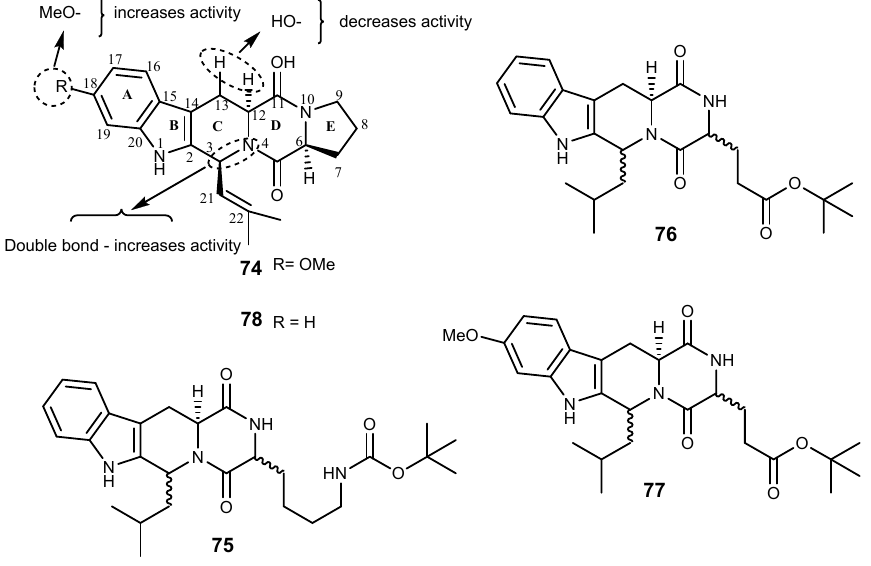
Figure 15. Structures of fumitremorgin C ( 74 ) and derivatives 75 – 78 and SAR for BCRP inhibition.